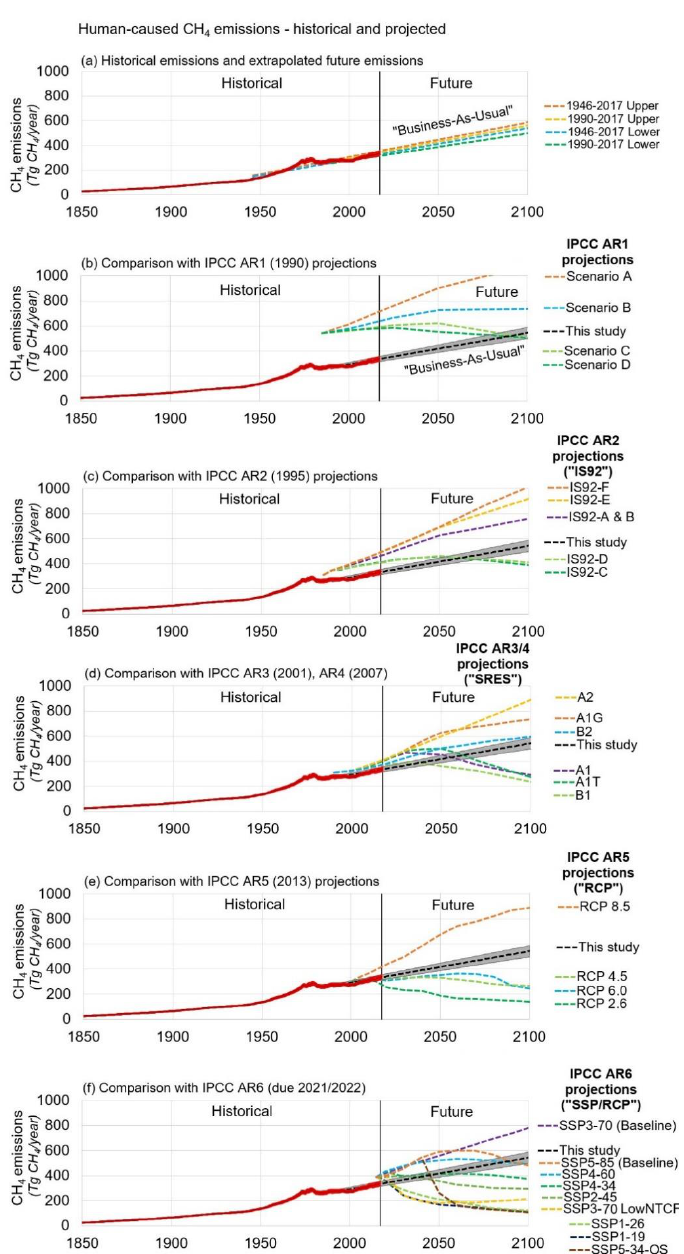
Figure 4. ( a ) Historical and projected “Business-As-Usual” CH 4 emissions. ( b – f ) A comparison of said Business-As-Usual projections to the projections considered by the various IPCC reports. The horizontal axes correspond to years. Details on the projections are provided in Table 2.